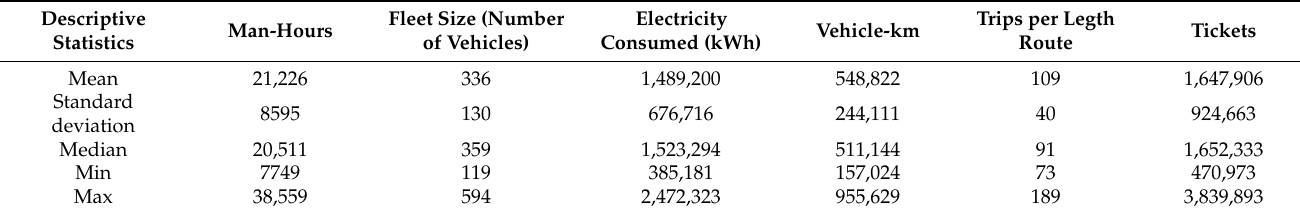
Table 1. Electric bus routes: Descriptive